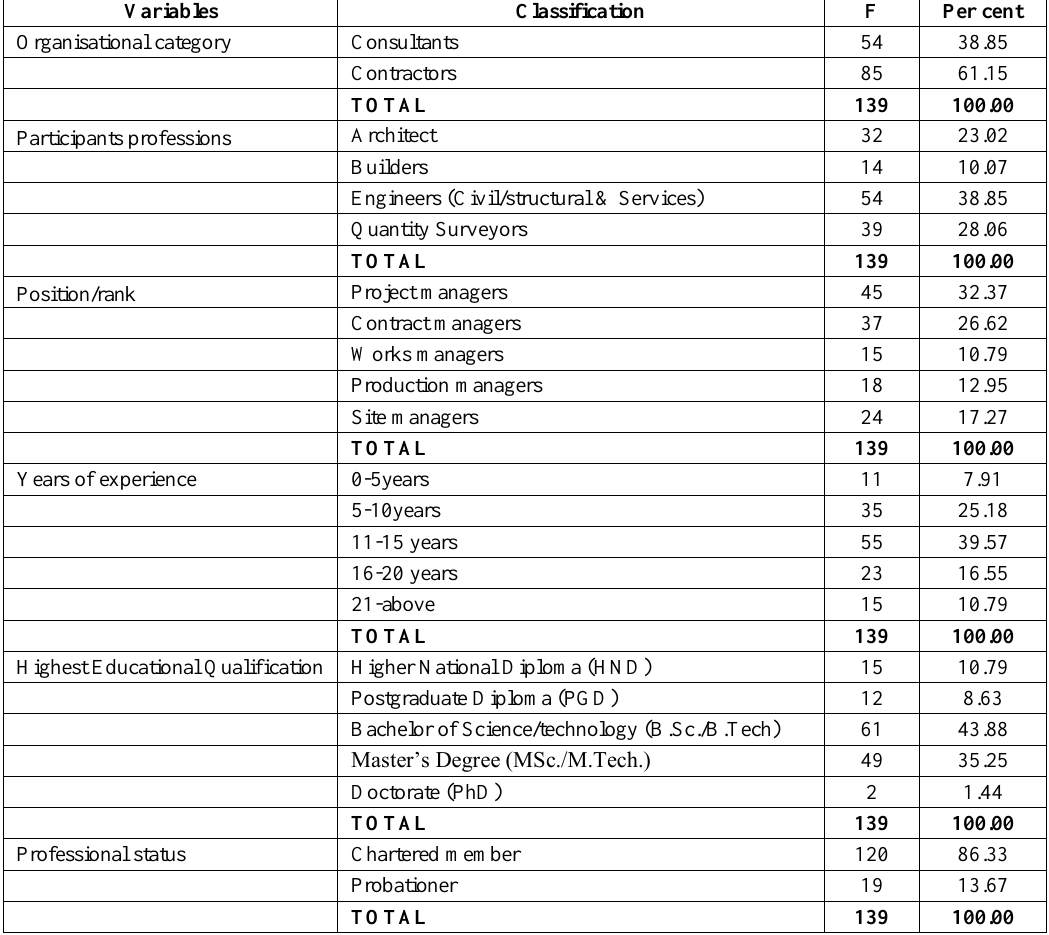
Table 4: Respondents background